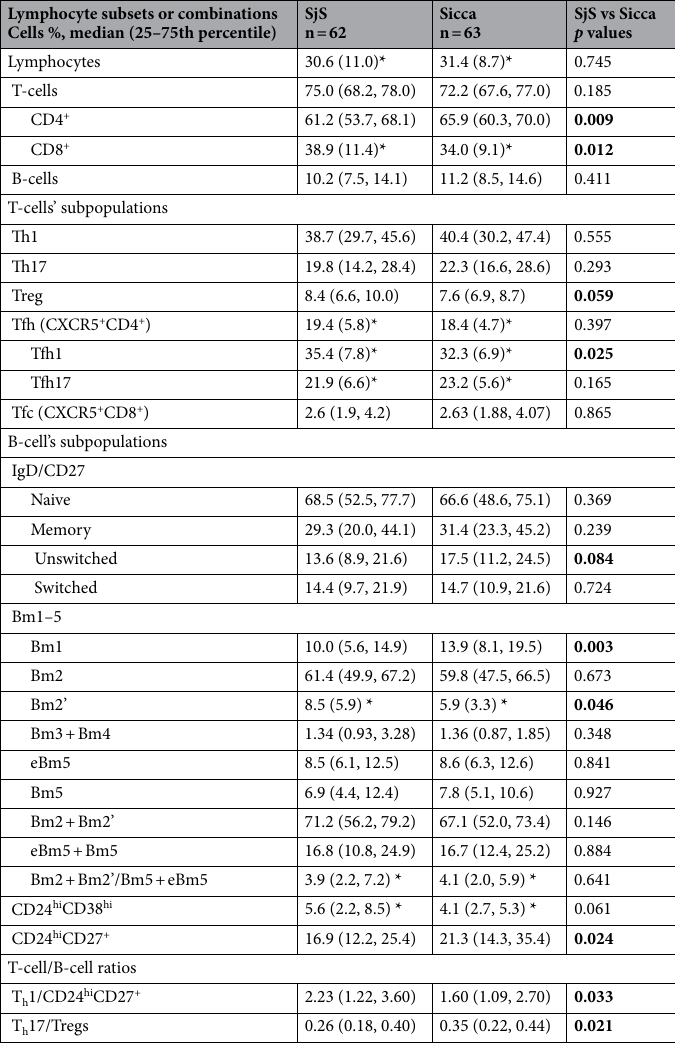
Table 2. Comparison of T and B-cell subsets percentages in SjS and Sicca groups. Bold numbers represent significance (p-values < 0.05) or relevance (p-values < 0.100); SjS, Sjogren’s syndrome. * indicates Mean and Standard